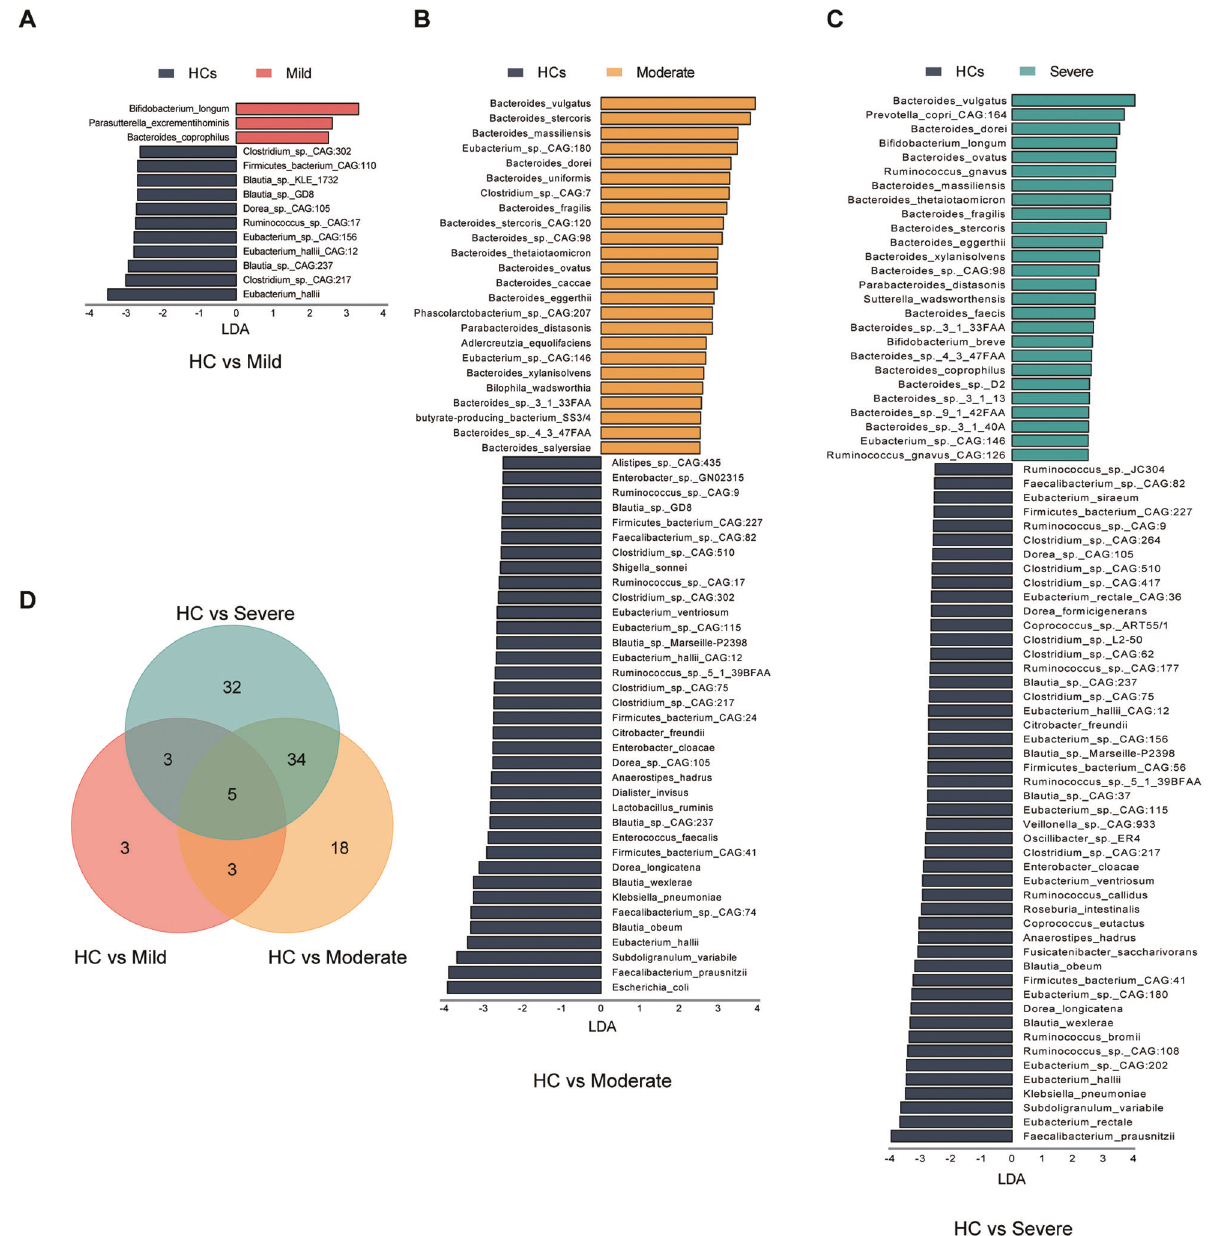
Fig. 3 Differentially enriched bacteria species of HCs and the 3 MDD subgroups. LDA Effect Size (LEfSe) analysis was performed to identify the bacteria that were differentially enriched in HCs and the 3 MDD subgroups in pairs (LDA > 2.5, p < 0.05). A – C Bar plot displayed the differentially enriched species between HC and MDD subgroups. D Venn diagram showed that moderate and severe group shared 39 differentially enriched bacteria, while only 5 bacteria were shared in the 3 MDD